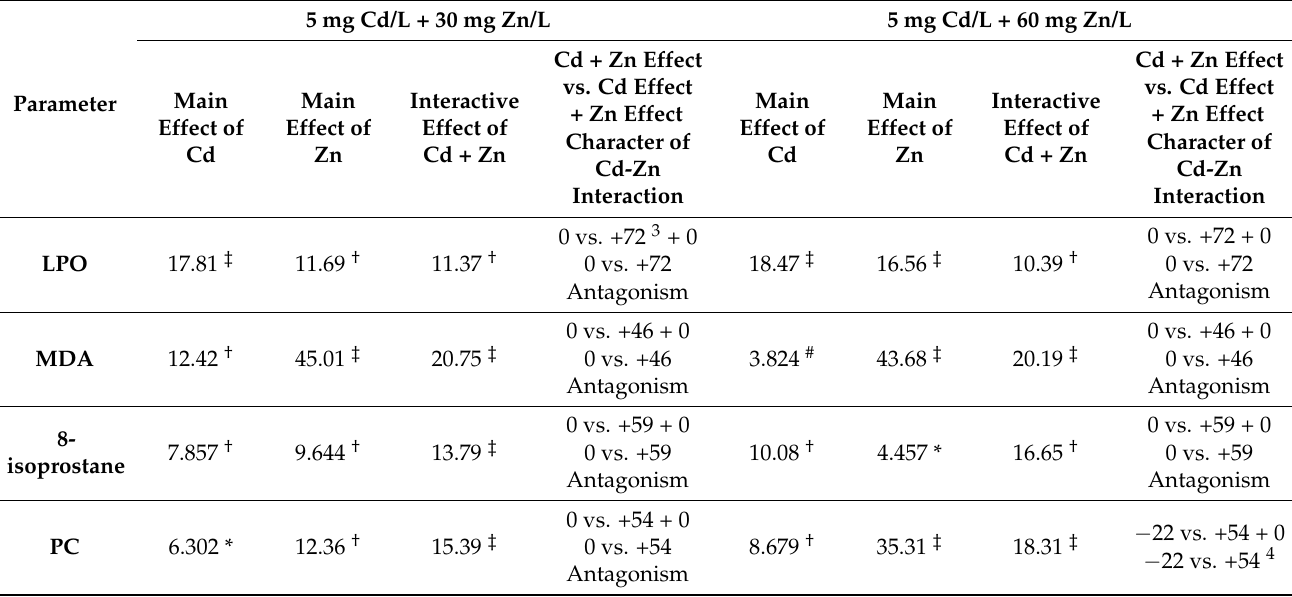
Table 6. Interactive and main effects of cadmium (Cd) and zinc (Zn) on the concentrations of lipid peroxides (LPO), malondialdehyde (MDA), 8-isoprostane, and protein carbonyls (PC) in the brain tissue of male rats 1,2 . 5 mg Cd/L + 30 mg